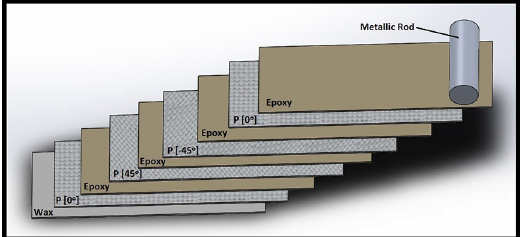
Figure 2. Layer sequence and fabric orientation on the tested [0º/45º/-45º/0º] T